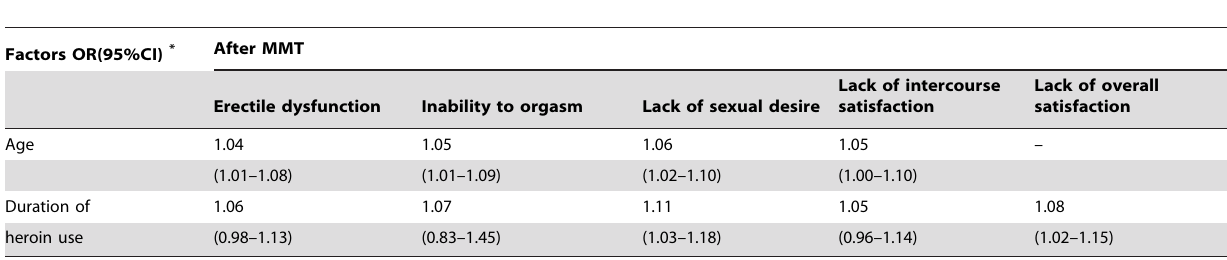
Table 5. Multivariate analysis of factors associated with sexual dysfunction after